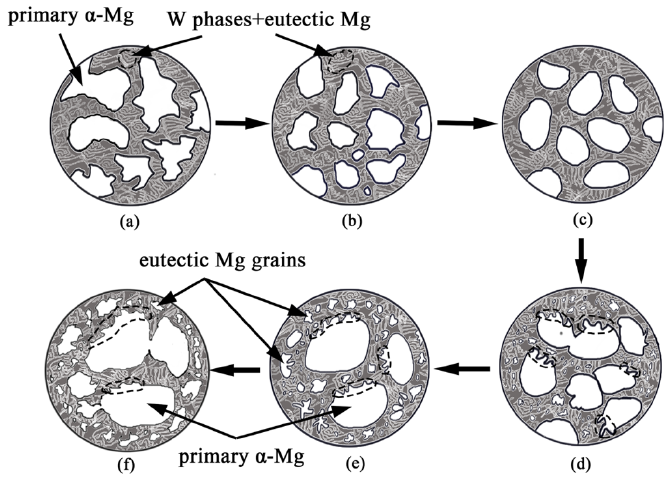
Figure 10. Schematic diagram of microstructure evolution in Mg–10Zn–4Y–6.8Gd during isothermal heat treatment: ( a ) as-cast microstructure; ( b )–( c ) microstructure evolution with only α-Mg grains growth; ( d )–( e ) microstructure evolution after appearance of eutectic Mg grains.